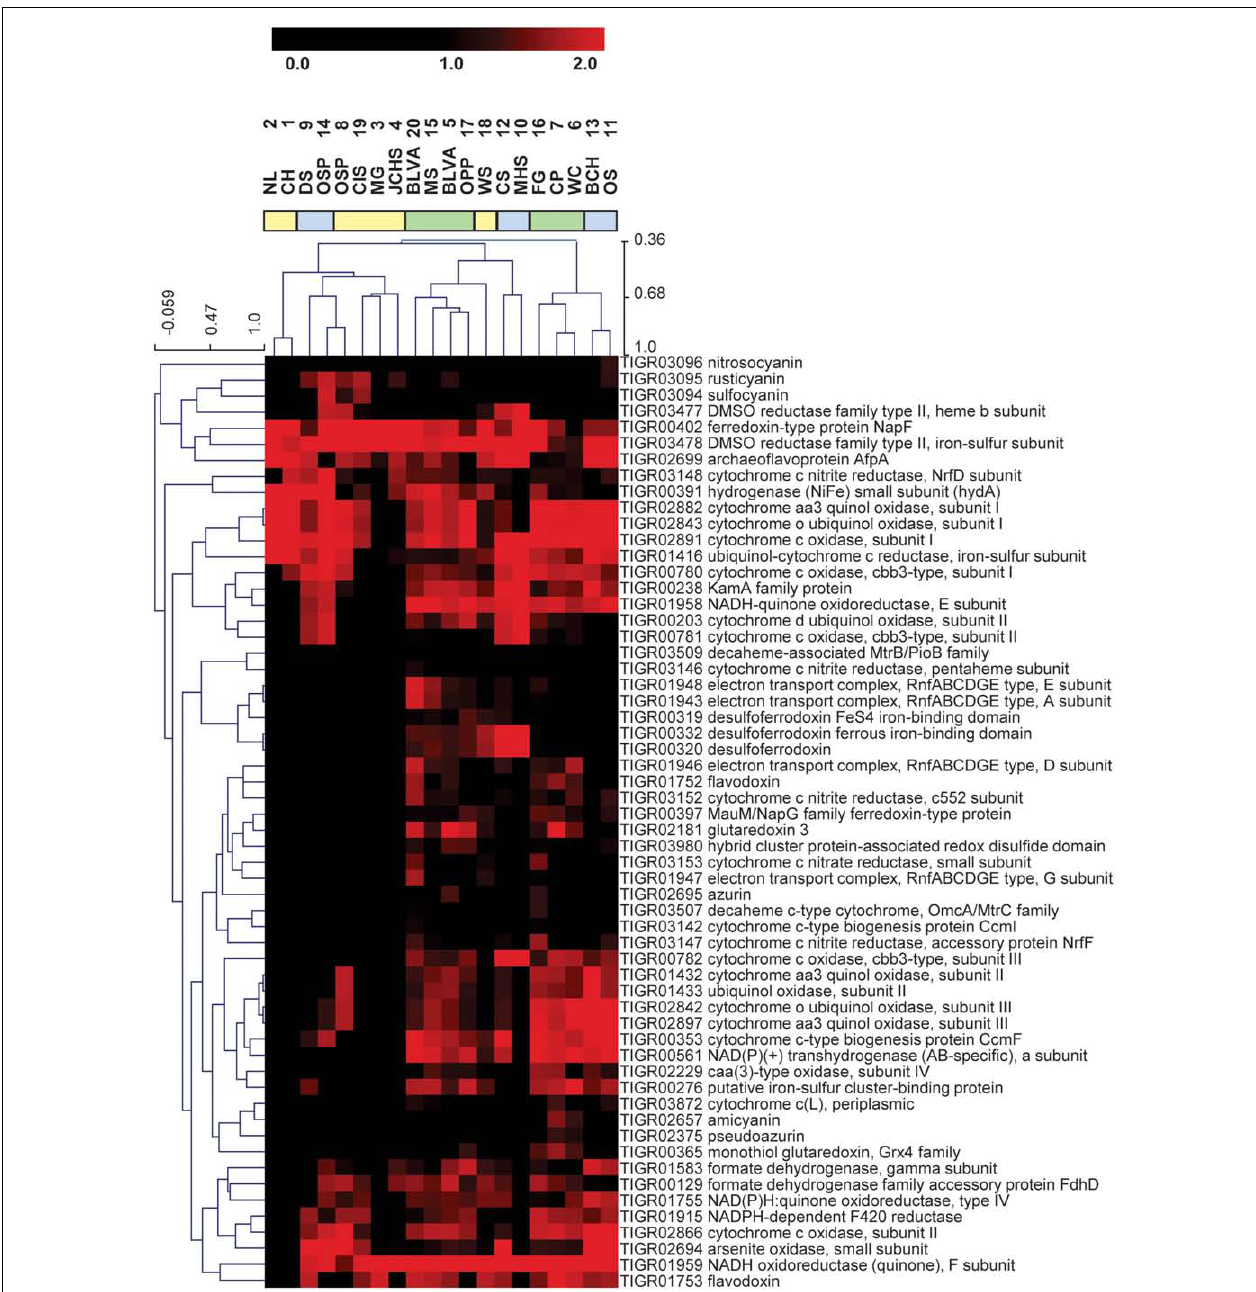
FIGURE 8 | Hierarchical clustering of metagenomes using relativeTIGRFAM family abundances of genes in theTIGRFAM category “Electron Transport” . Note that the abundance data has not been standardized, but rather log2-transformed (absolute abundances are